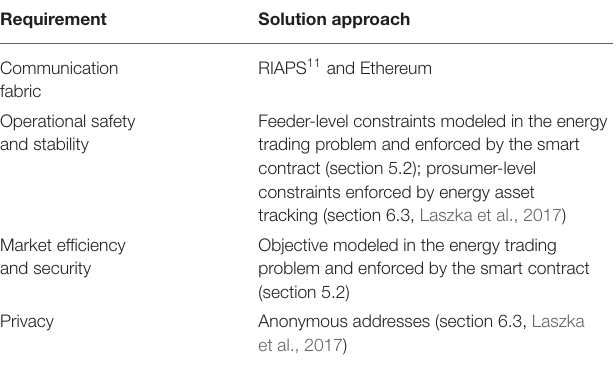
TABLE 3 | Requirements and proposed